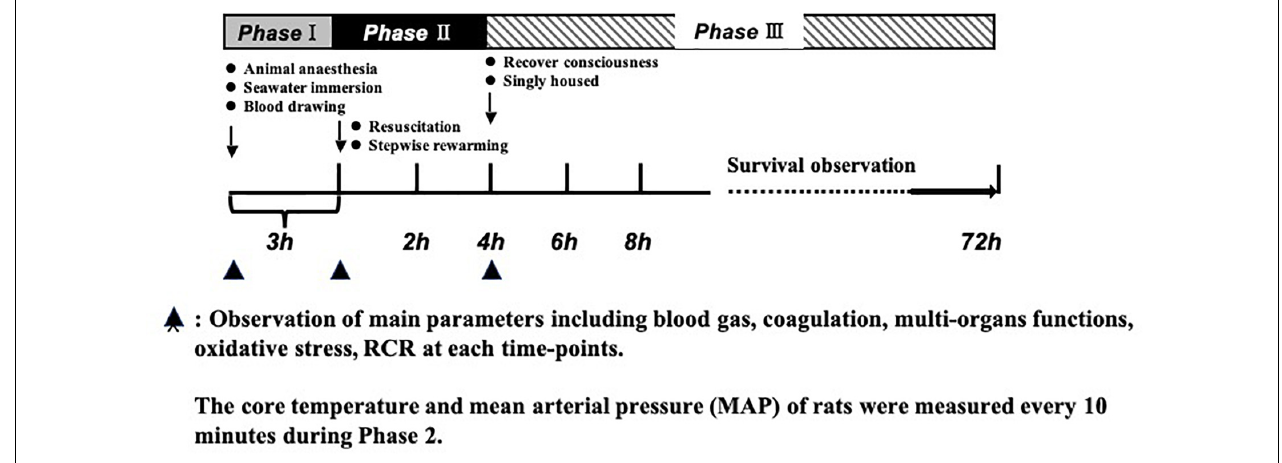
FIGURE 1 | Timeline of the experimental protocol. Phase 1: establishment of model of hemorrhagic shock combined with seawater immersion. Phase II: administration of fluid (2 × volume of blood loss) and stepwise rewarming. Phase III: observation period including animal survival, coagulation parameters, multi-organ function, MDA, ROS, and RCR. (cid:78) Observation of main parameters including blood gas, coagulation, multi-organ functions, oxidative stress, and RCR at each time point.